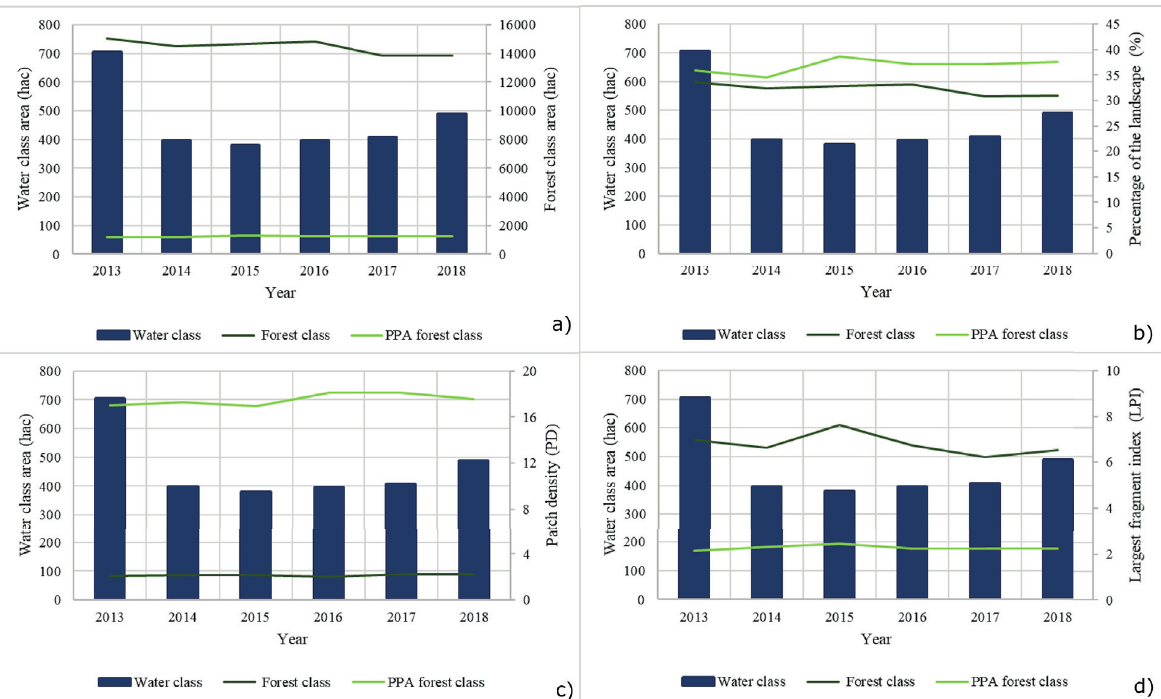
Figure 2. Var iation of confi guration metrics along landscape, where a) class area - CA, b) percentage of the landscape - PLAND, c) patch density - PD and d) largest fragment index